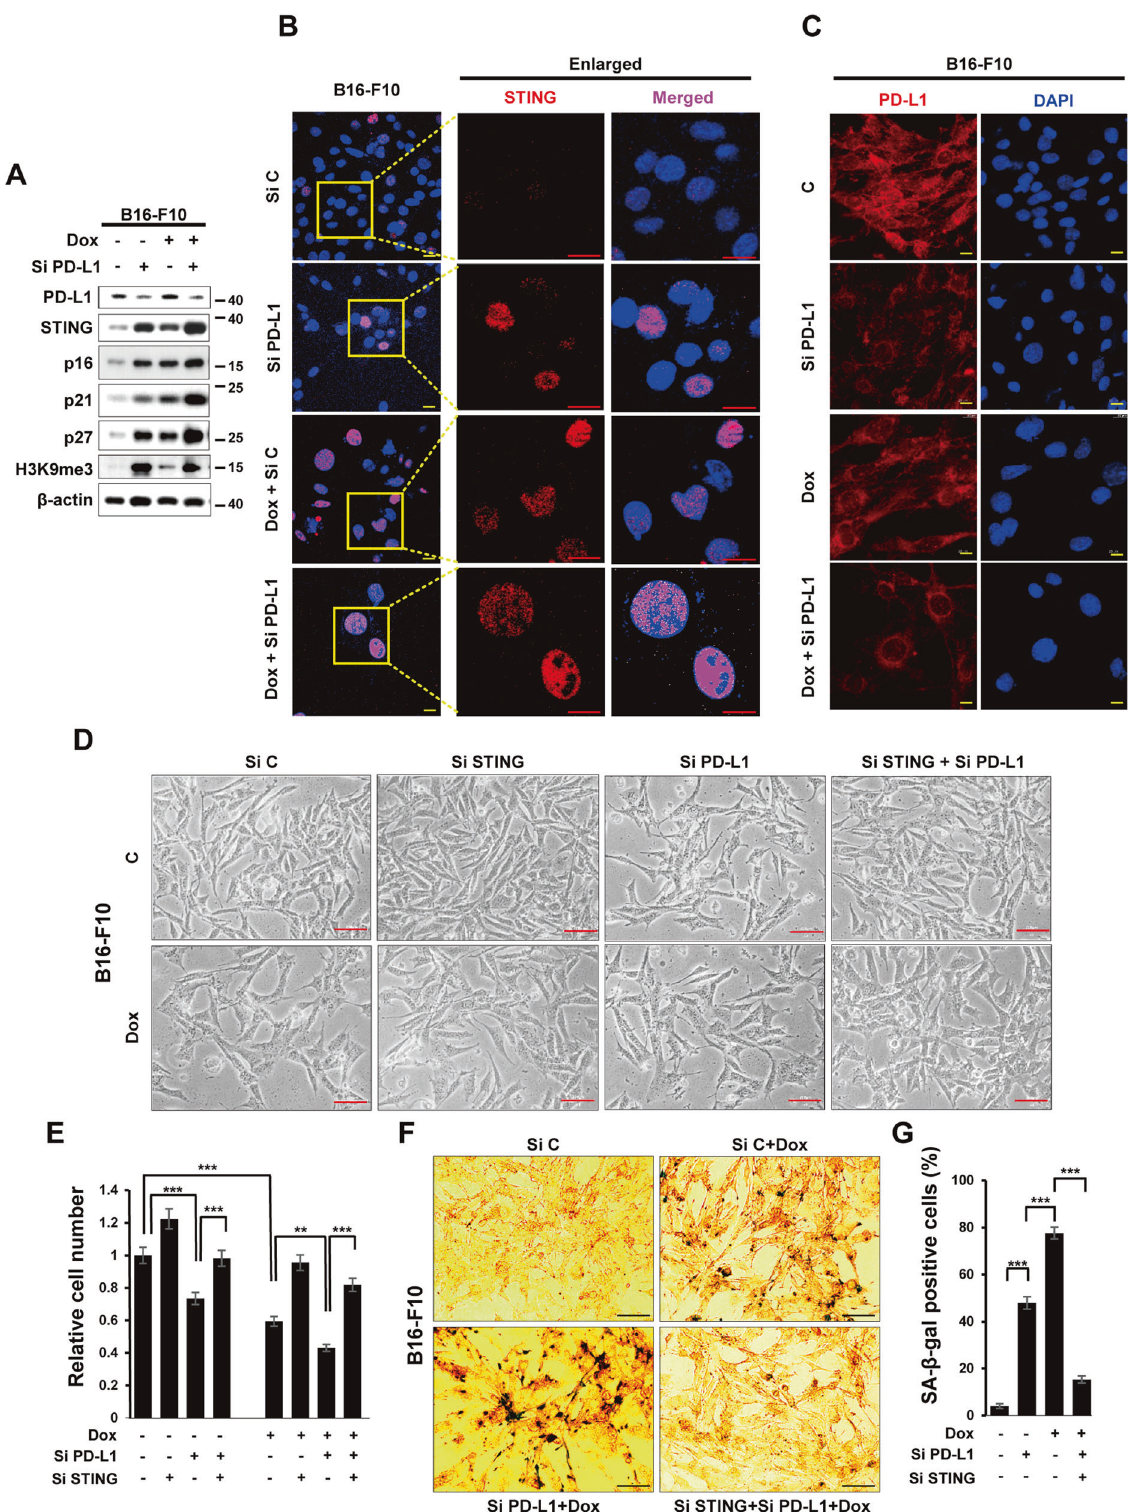
induced by SiPD-L1 treatment and even more increased in Dox treatment together (Fig. S4A), and the manner is consistent with the degree of SA- β -Gal activity (Fig. S4B). SASP is required for activation of STING pathway. IL-6 and IL-8 expression were also upregulated in SiPD-L1 treated group and more increased by